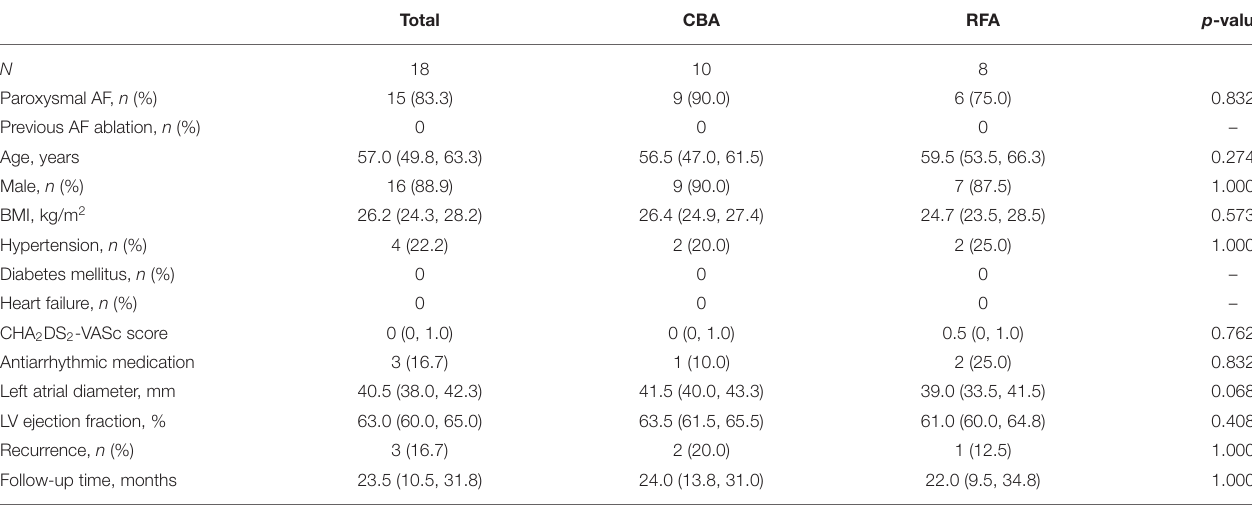
TABLE 1 | Baseline characteristics of the study population.